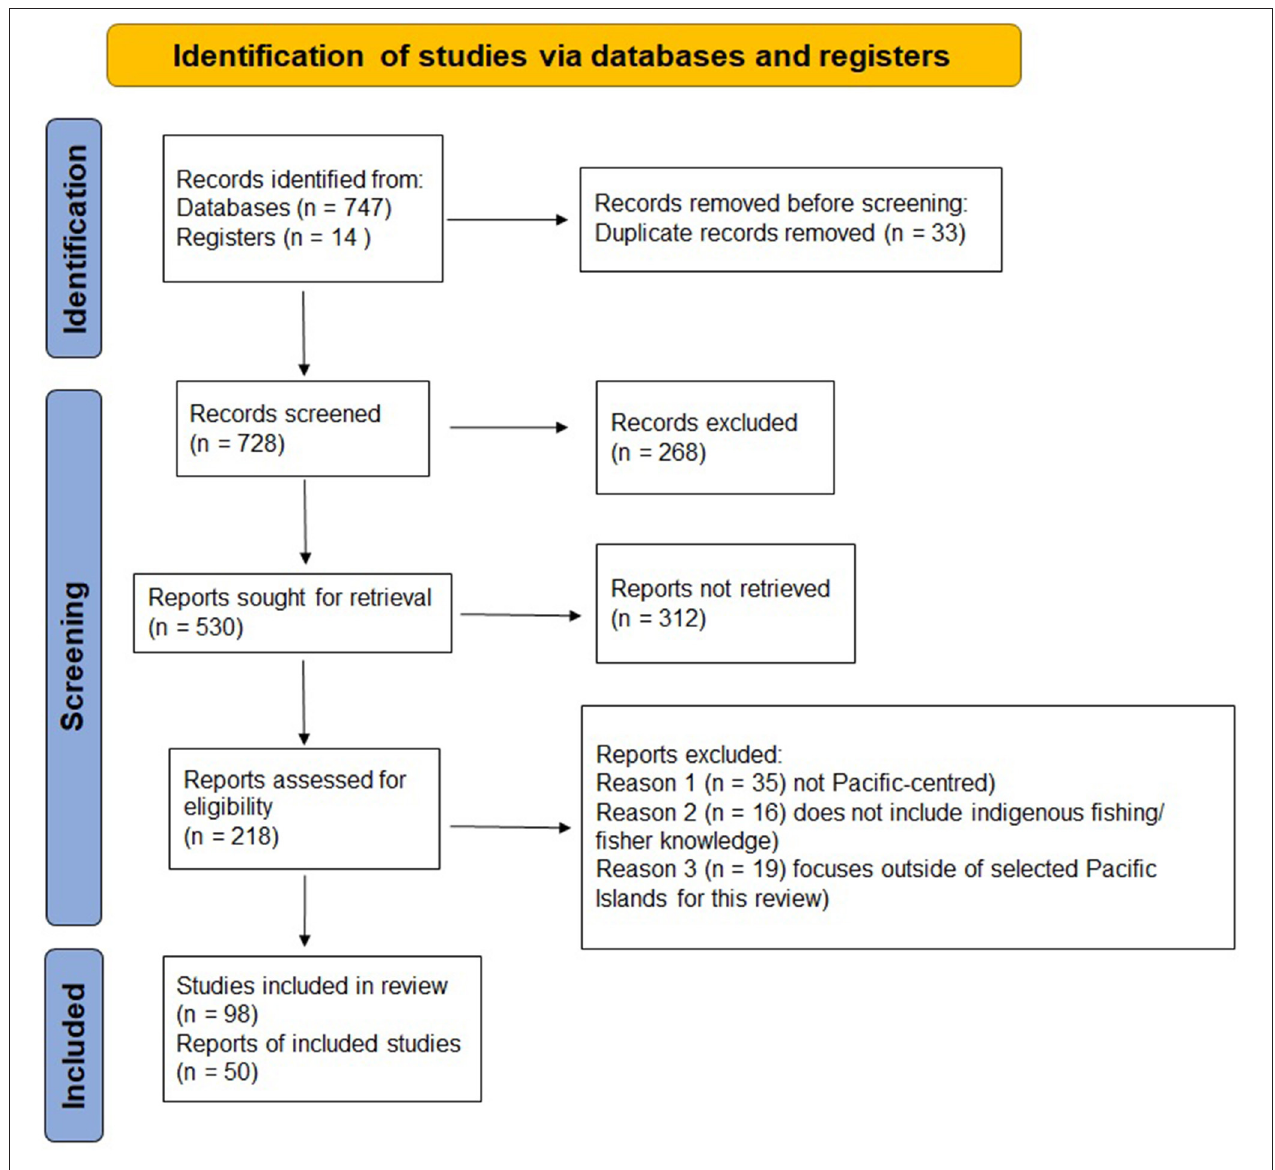
FIGURE 2 | PRISMA flow chart of this systematic review according to Page et al. (2021).